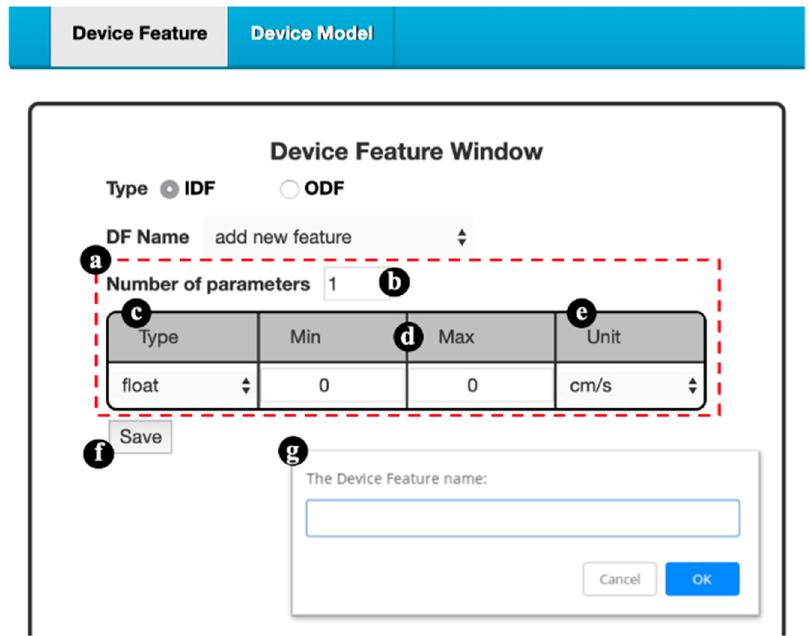
Figure A3. Device feature creation.